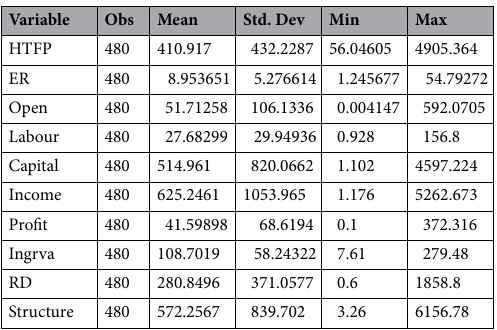
Table 1. Descriptive statistical analysis of each variable.